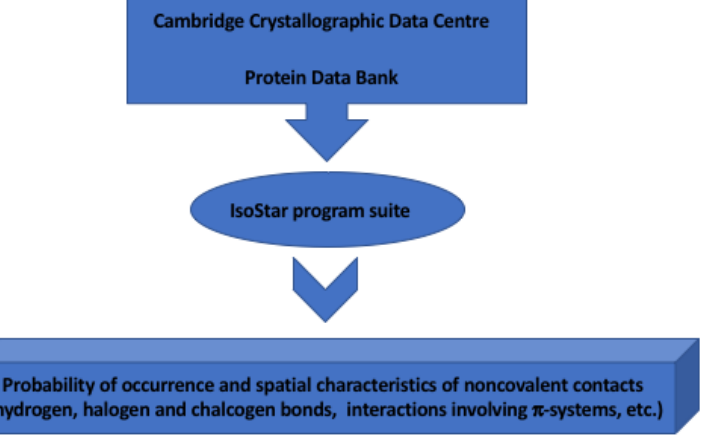
Figure 1. IsoStar program suite—an automatic web application for studies of noncovalent interactions in crystals of chemical compounds.